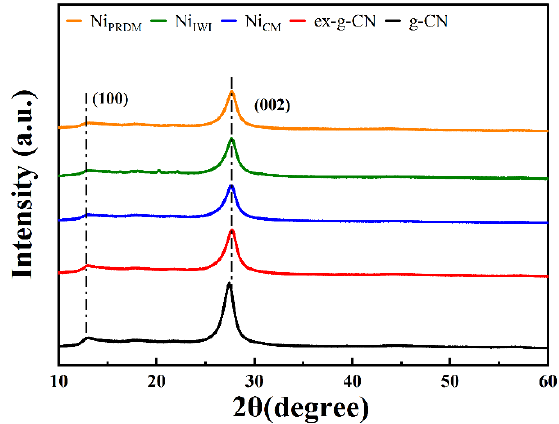
Figure 1. XRD patterns of g-CN, ex-g-CN, and Ni-loaded ex-g-CN synthesized using the incipient wet impregnation (IWI) method, colloidal method (CM), and precipitation deposition method